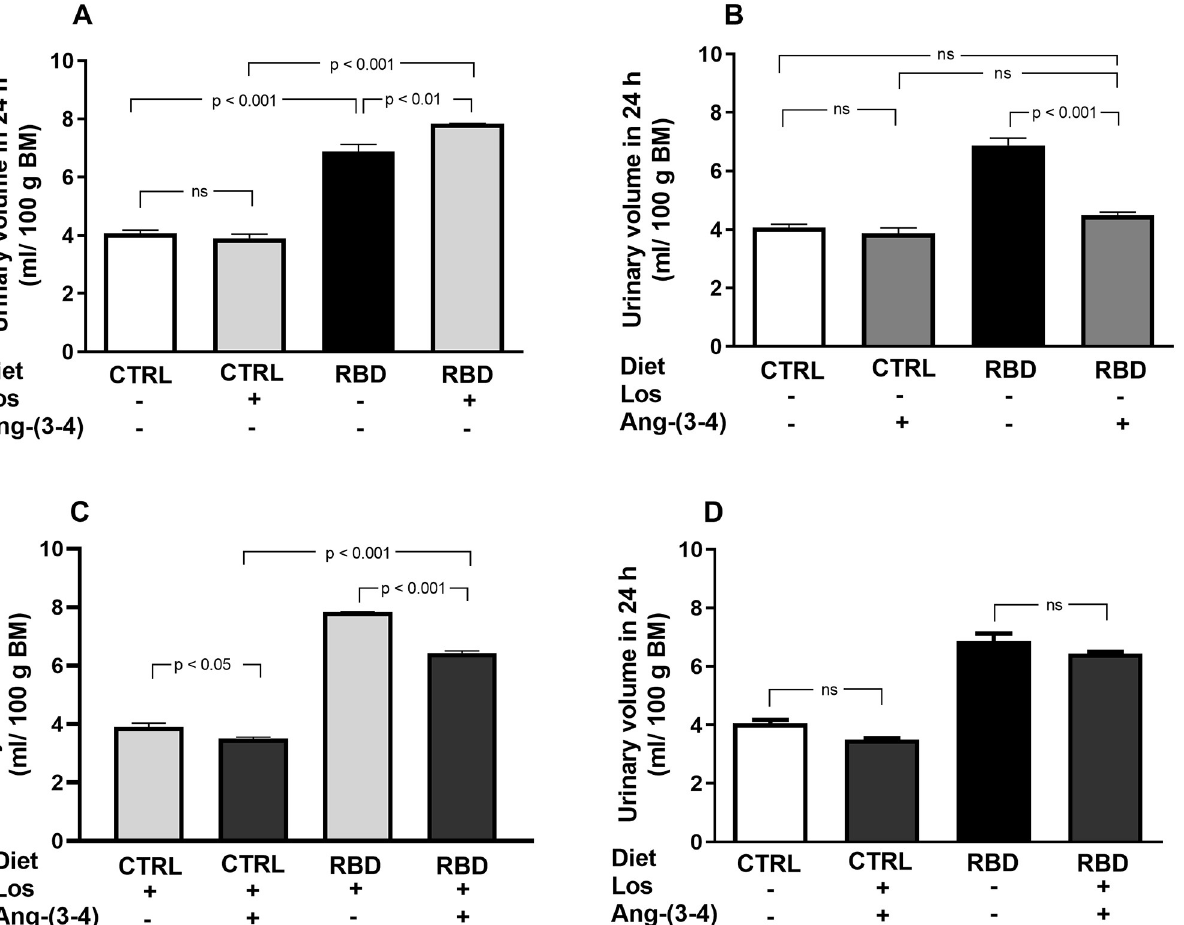
Fig 8. Urinary volume in 24 h per 100 g BM. Urine samples were collected between 90 and 91 days, except for Ang-(3–4)-treated rats, which were collected between 91 and 92 days. (A) Responses to Losartan. Comparison of the urinary volume of CTRL and RBD rats without chronic administration of Losartan, and effects of Losartan administration, as indicated on the abscissa . (B) Responses to Ang-(3–4). Effects of oral administration of a single dose of Ang-(3–4) on the urinary volume of CTRL and RBD rats, as indicated on the abscissa . (C) Responses to Ang-(3–4) in rats previously treated with Losartan. Effects of oral administration of a single dose of Ang-(3–4) on the urinary volume of CTRL and RBD rats previously treated with Losartan, as indicated on the abscissa . (D) Effects of combined Losartan+Ang-(3–4) administration. Comparison of urinary volume between untreated CTRL and RBD rats vs . CTRL and RBD rats that were chronically given Losartan and a single dose of Ang-(3–4), as indicated on the abscissa . Bars are mean ± SEM; n = 5 (CTRL), n = 8 (RBD), n = 5 (CTRL+Los), n = 6 (RBD+Los), n = 5 (CTRL+Ang-(3–4)), n = 8 (RBD+Ang-(3–4)), n = 5 (CTRL+Los+Ang-(3–4)), n = 6 (RBD+Los+Ang-(3–4)). Differences between means were analyzed using one-way ANOVA followed by Bonferroni’s test for selected pairs. P values are indicated within the